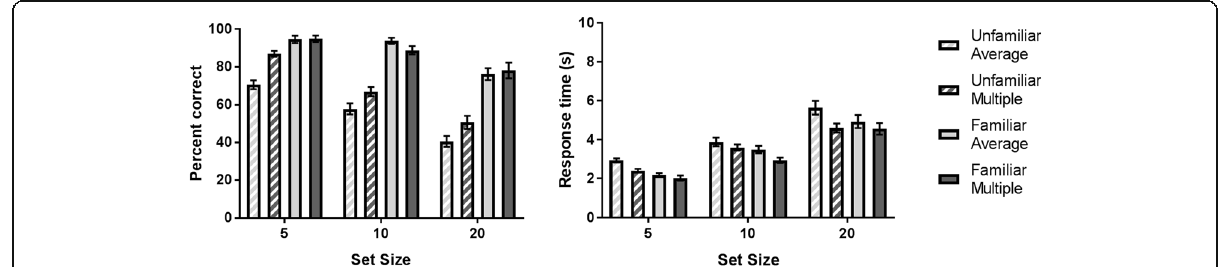
Fig. 3 Mean accuracy and response time for Experiment 3 by Set Size. Error bars denote ±1 standard